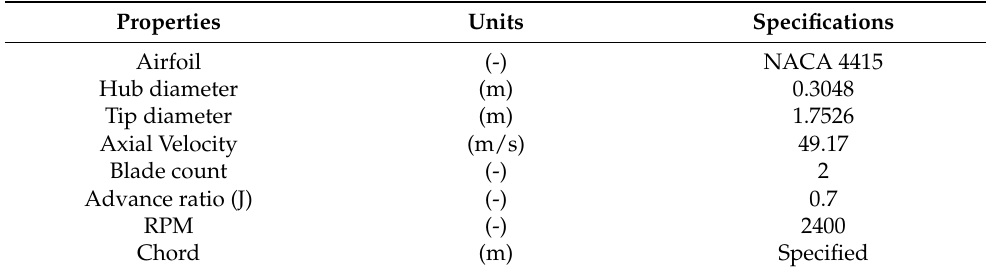
Table 1. Design specifications of a light aircraft and performance coefficients compared with py_BEM-generated design.